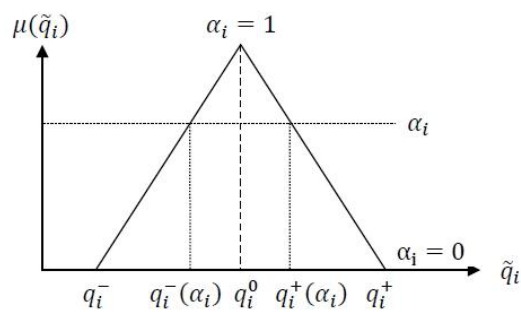
Figure 2. Fuzzy 𝛼 -cut representation of the uncertain parameter. Figure 2. Fuzzy α -cut representation of the uncertain